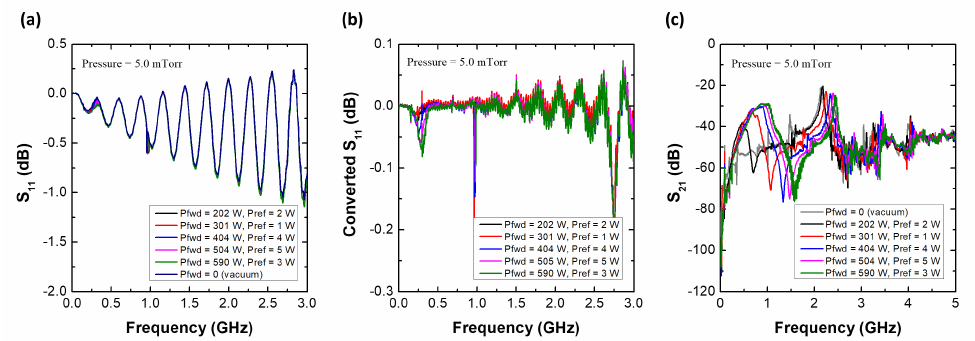
Figure 9. ( a ) S 11 spectra and ( b ) converted S 11 spectra [defined as S 11 (plasma)–S 11 (vacuum)] of the MOLE probe. ( c ) S 21 spectra of the cutoff probe with various rf powers (202–590 W) at a pressure of 5